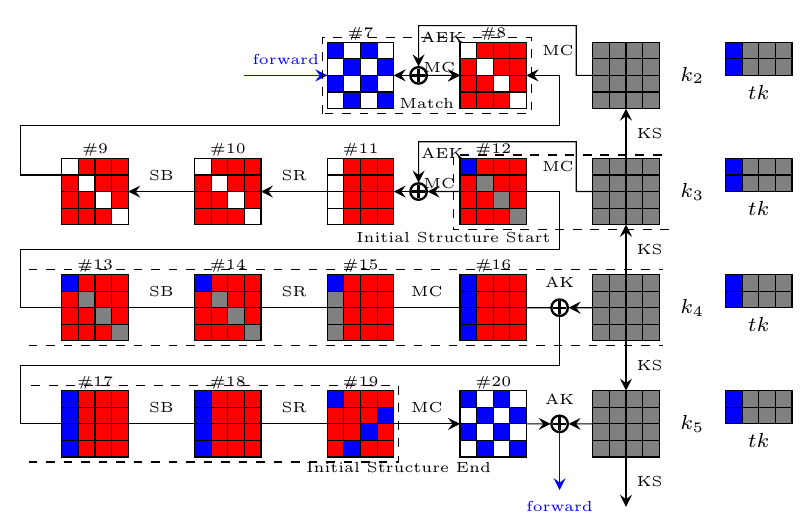
Figure 9: Introducing free bytes in the key to improve the 7-round preimage attack on Kiasu-BC hashing mode